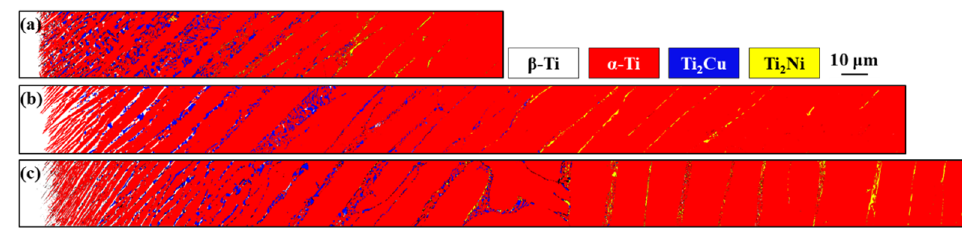
Figure 5. EBSD crystallographic analysis results of Ti-1553/Ti–Cu–Ni/CP-Ti joint brazed at 1243 K for ( a ) 3, ( b ) 30, and ( c ) 60 min.